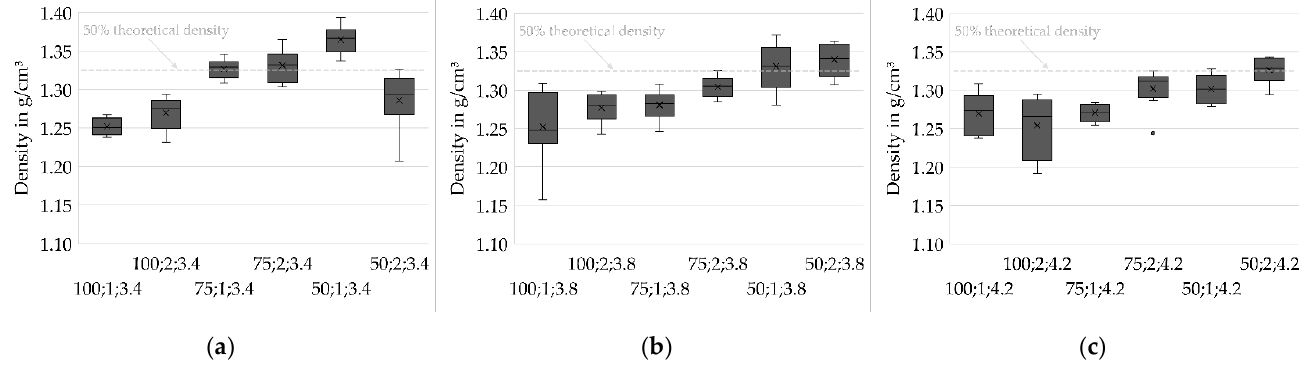
Figure 7. Density distributions for different drying intensities. A reduction in layer thickness results in higher densities. Drying Point 2 shows higher densities in most cases. ( a ) PAV = 3.4 V, n = 8; ( b ) PAV = 3.8 V, n = 8; ( c ) PAV = 4.2 V, n = 8.